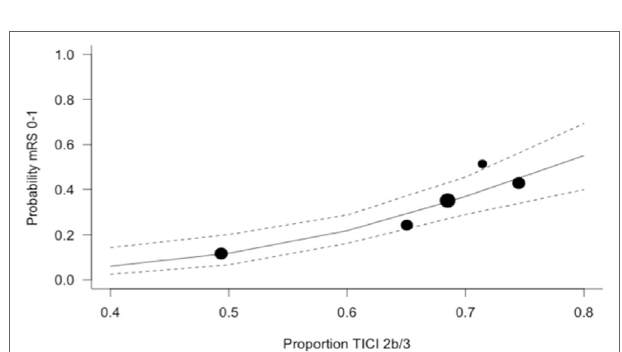
FigUre 3 | Predicted probability of modified Rankin Scale score 0–1 by modified thrombolysis in cerebral ischemia grade 2b/3, with dashed line showing 95% CI, and size of markers inversely proportional to each within-trial SD (intention-to-treat analysis).